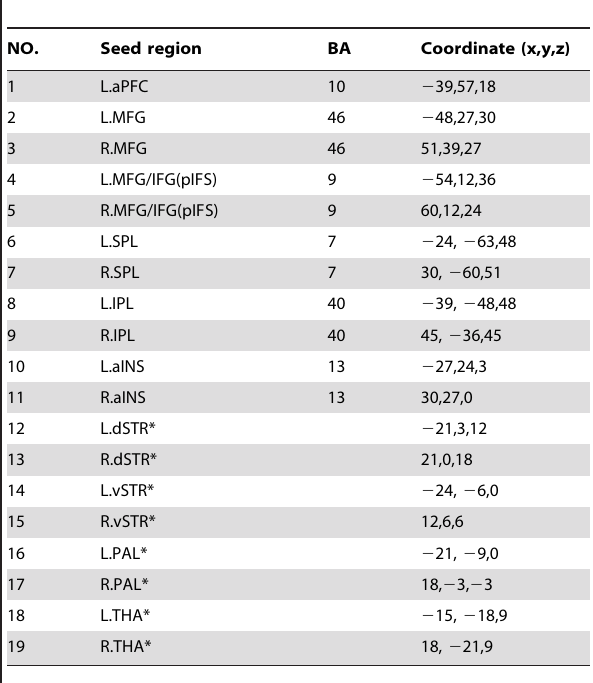
*Seed regions were generated from 12-mm diameter spheres centered on the peak foci of the region. The other seed regions were generated from 18-mm diameter spheres centered on the peak foci. For details, please see the main text. Abbreviations: L: left; R: right; aPFC: anterior prefrontal cortex; aINS: anterior insula; BA: Brodmann area; dSTR: dorsal striatum; IFG: inferior frontal cortex; IPL: inferior parietal lobe; MFG: middle frontal cortex; PAL: pallidum; pIFS: posterior inferior frontal sulcus; SPL: superior parietal lobe; THA: thalamus; vSTR: ventral striatum.